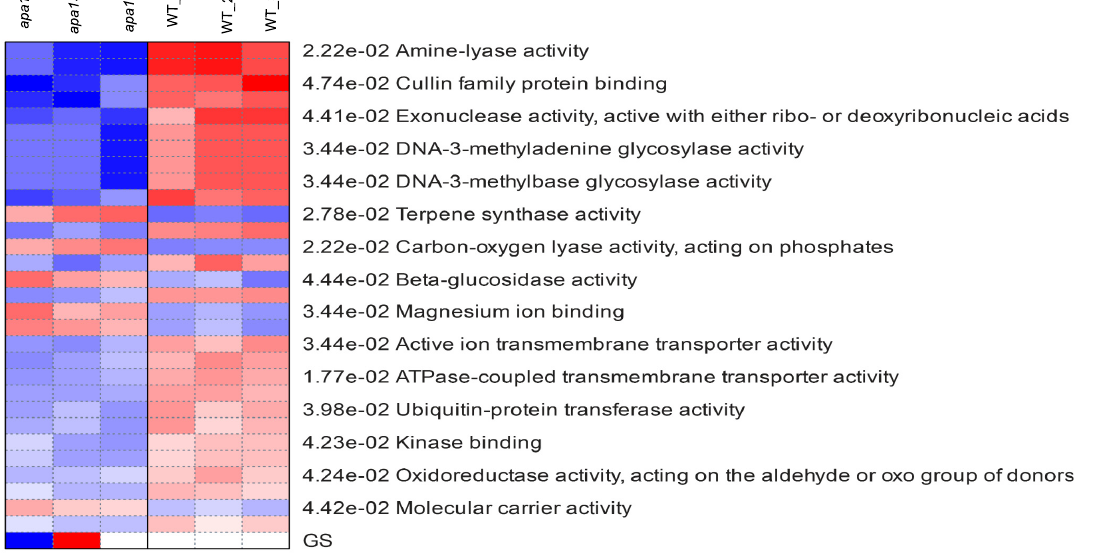
Figure 4. KEGG expression profiles of DEGs using PGSEA. KEGG terms associated with biological functions of DEGs using PGSEA ( A ); KEGG terms associated with molecular functions of DEGs using PGSEA ( B ). Red and blue indicate upregulated and downregulated genes,